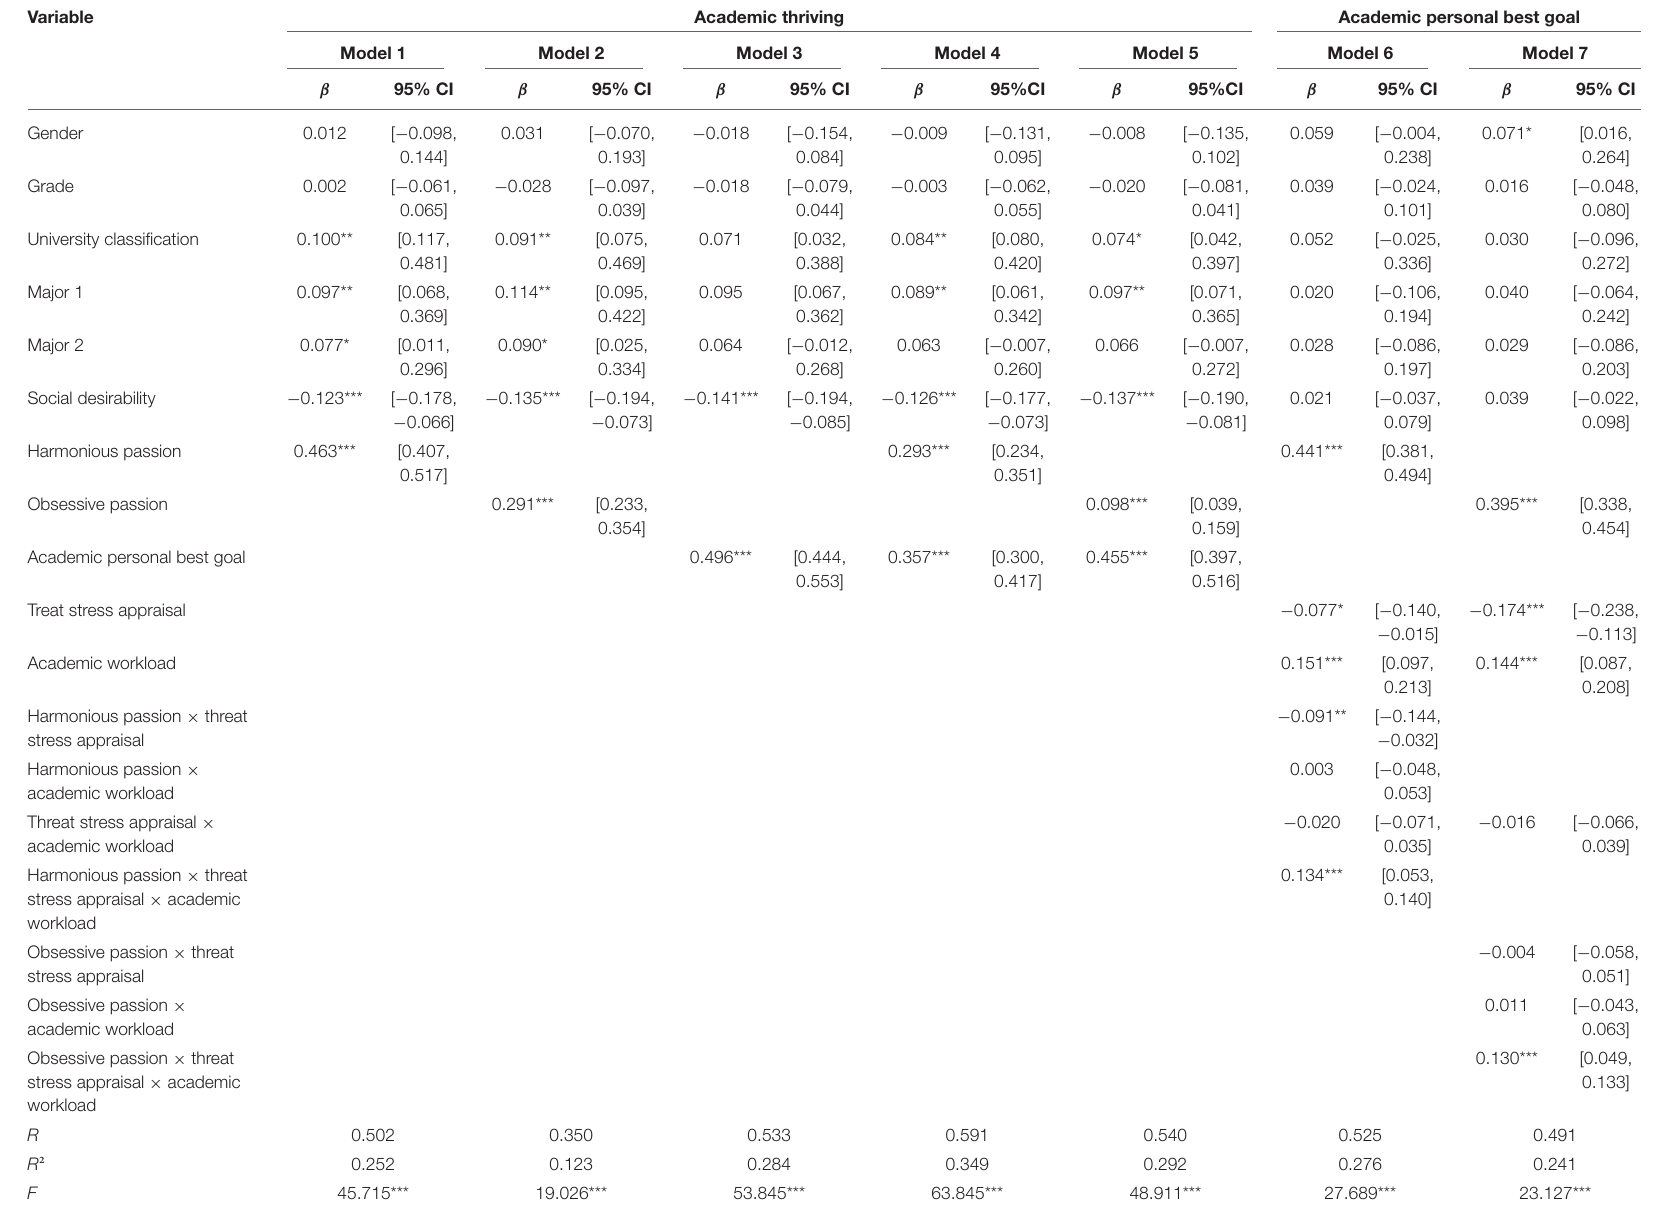
TABLE 2 | Hierarchical linear regression results.